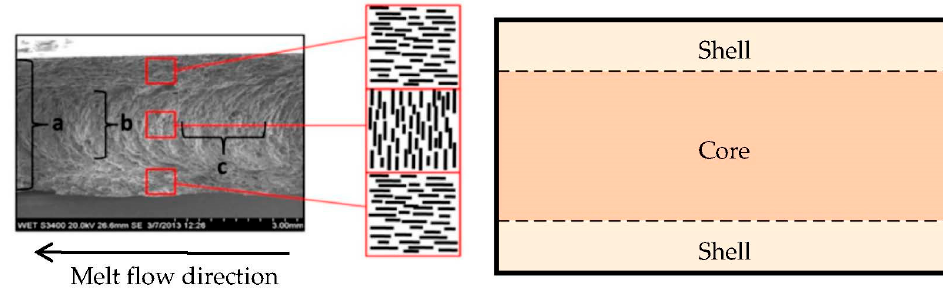
Figure 4. The internal structure of the test specimen in the study conducted by Grundler et al.